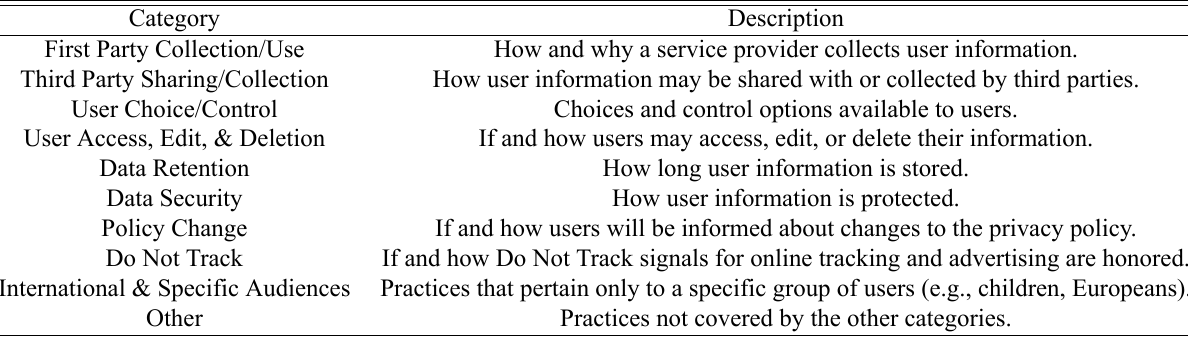
Table 1. Categories of data practices annotated in the corpus.